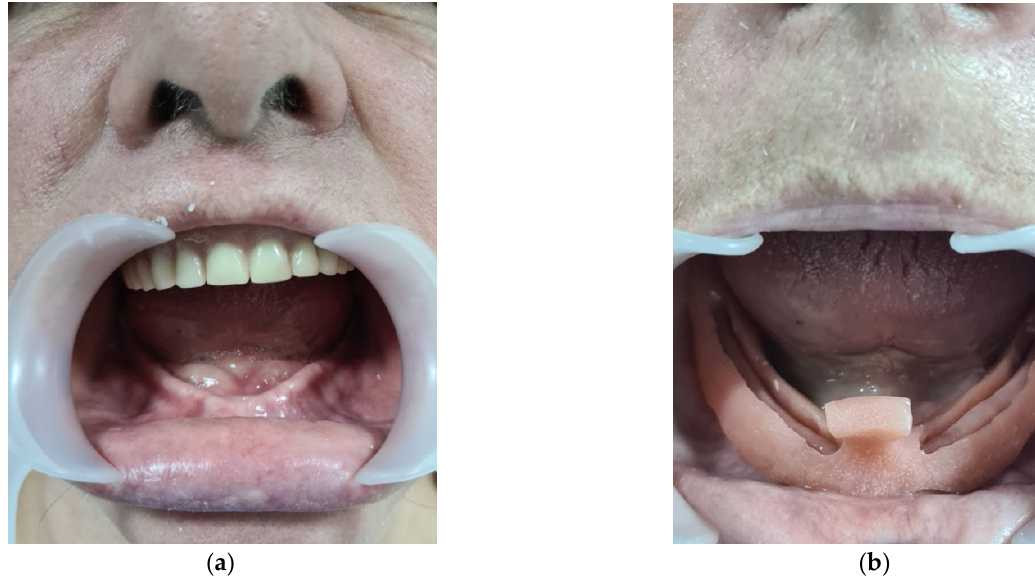
Figure 13. ( a ) fronto-lateral mandible flabby mucosa; ( b ) fenestrate custom tray.